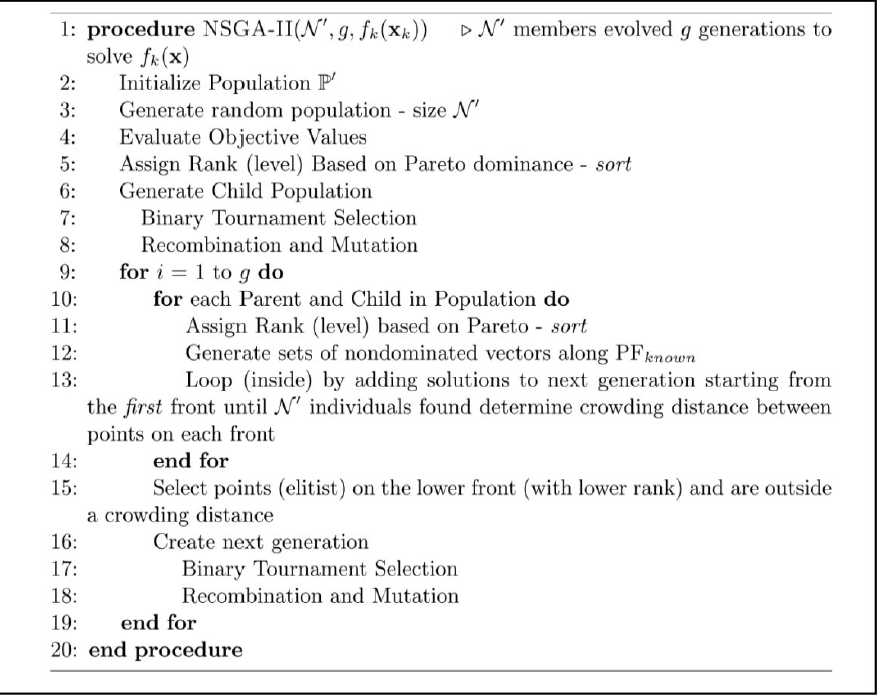
Figure 2. Pseudo-code of the NSGA-II (Coello et al.,